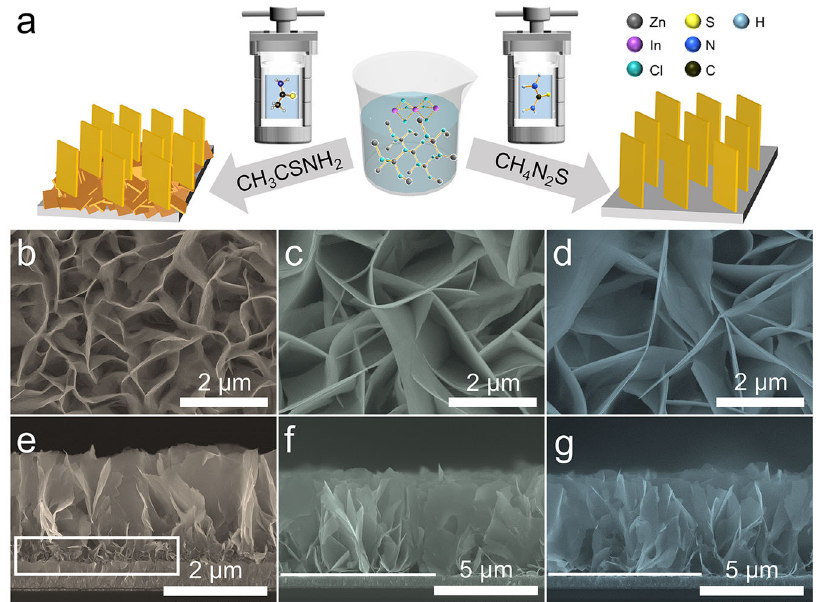
Fig. 1 Synthesis and morphology comparison of photoanodes. a The schematic diagram for the synthetic process of the photoanode. b – d Top-view and ( e – g ) cross-sectional SEM images of ZIS, ZISZ, and ZISZ/Fe nanosheet